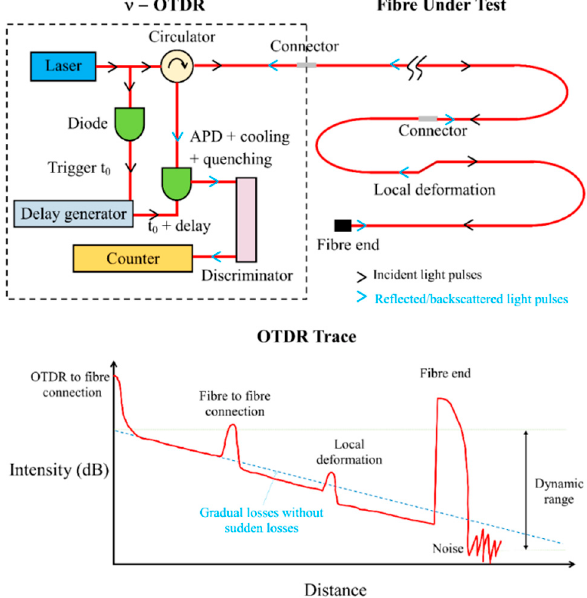
Figure 1. Working principles of photon-counting Optical Time Domain Reflectometer ( ν -OTDR) [26] and typical OTDR trace.